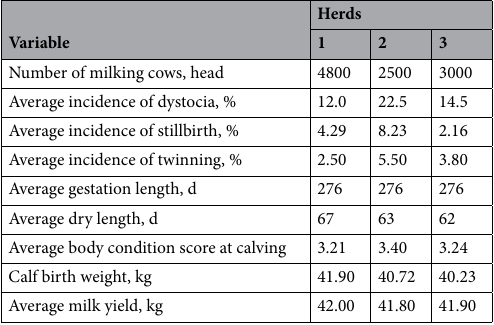
Table 1. Characteristics of the investigated herds.